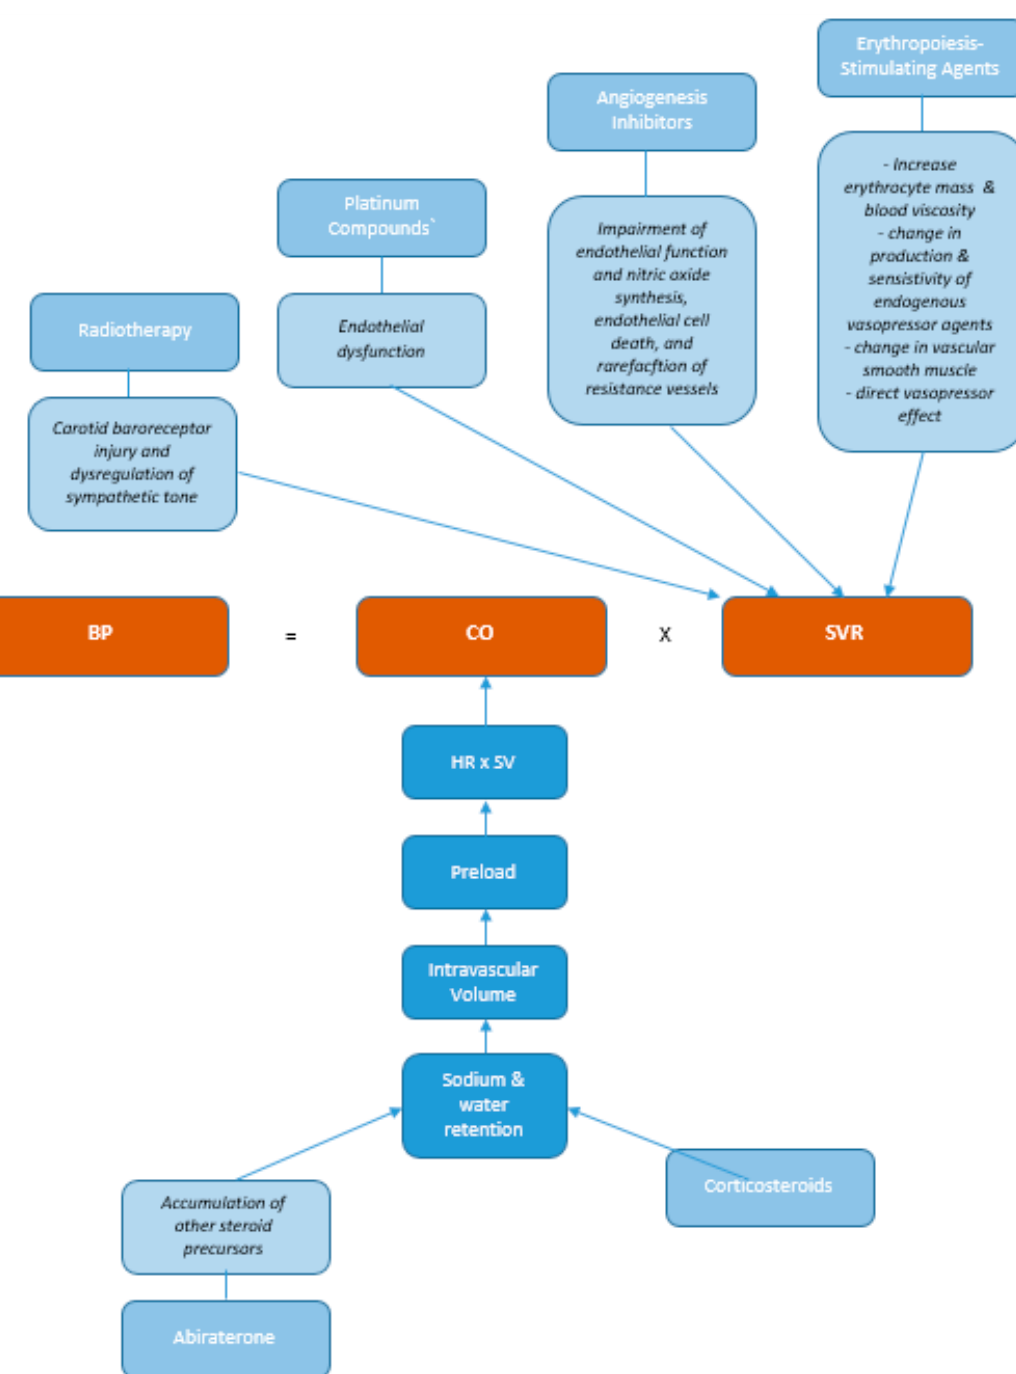
Figure 1. Pathophysiology of cancer therapies leading to hypertension. Outline of the pathophysiology of cancer therapies leading to hypertension. Cancer therapies can have various impacts on the systemic vascular resistance and cardiac output which ultimately has an effect on the blood pressure. BP: Blood pressure, CO: Cardiac output, SVR: Systemic vascular resistance.